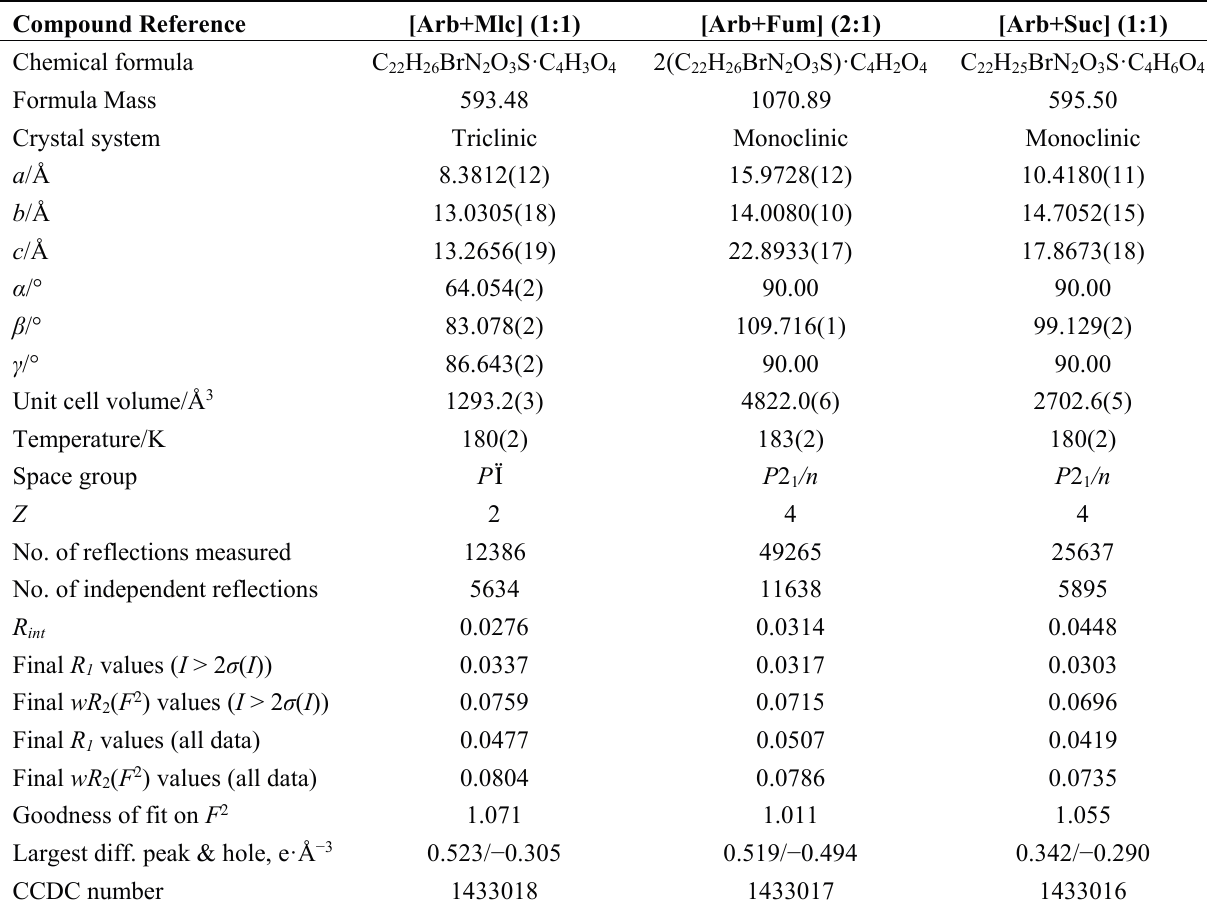
Table 1. Crystallographic data for arbidol multicomponent crystals. Arb :